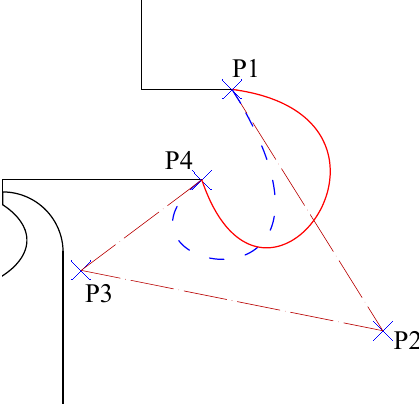
Figure 8. Detail of high voltage electrode contour. Initial (dashed blue) and optimized (solid red). Points P1, ..., P4 are the control points of the cubic Bézier curve.